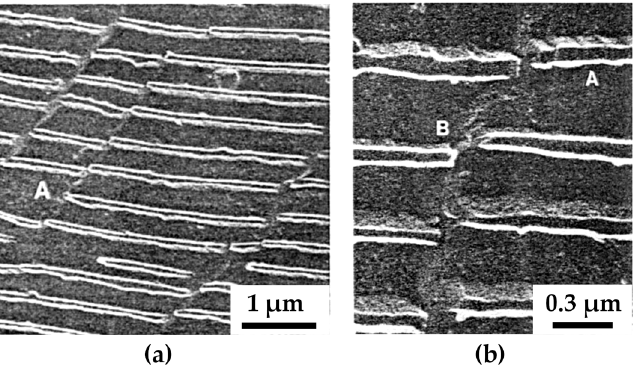
Figure 24. SEM micrographs showing the fracture of cementite lamellae caused by slip transfer. ( a ) and ( b ) are the SEM images at different magnifications. (Reprinted from Reference [22], with permission from